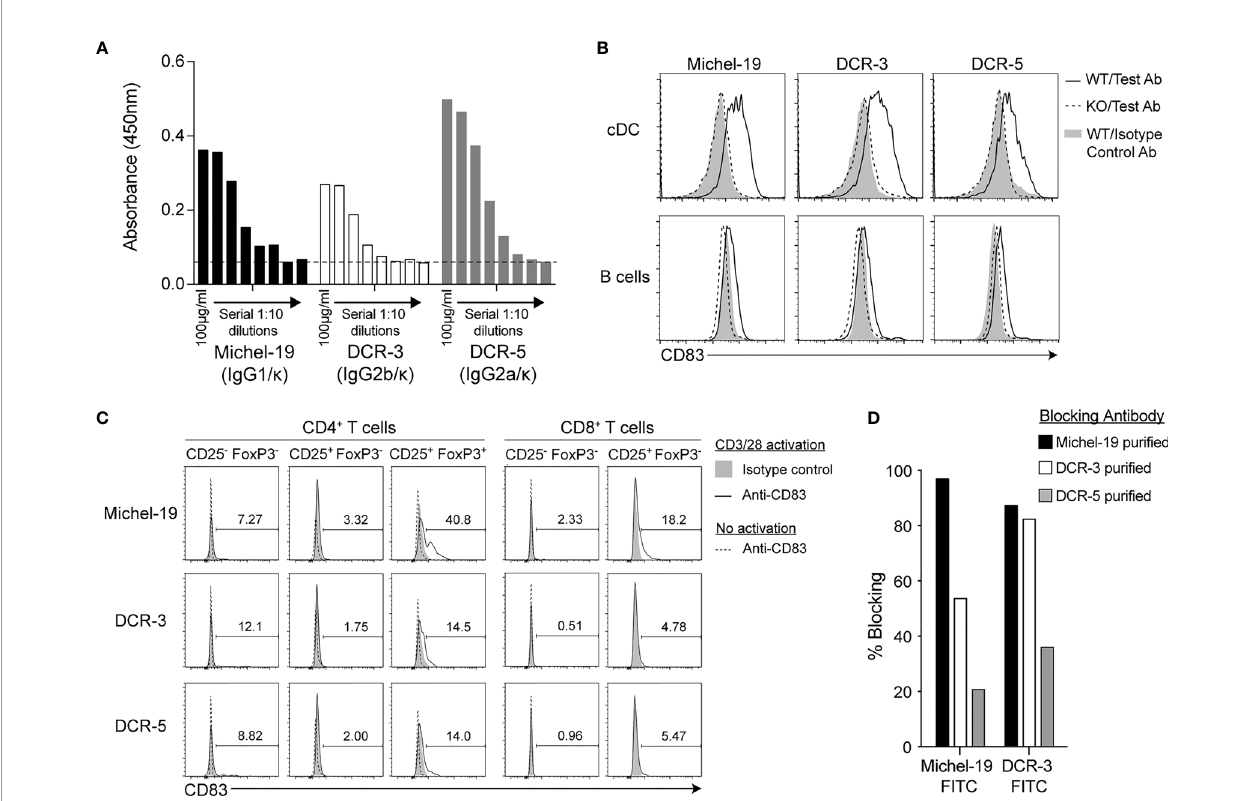
FIGURE 1 | Binding properties of rat anti-mouse CD83 antibodies DCR-5 and DCR-3. (A) Comparison of binding of DCR-5, DCR-3 and Michel-19 anti-CD83 antibody clones (1:10 serial dilutions starting at 100 µg/ml) to plates coated with recombinant mouse CD83-His by ELISA. Dashed line marks the absorbance in the no antibody control. Binding of 20 µg/ml Michel-19, DCR-3 or DCR-5 antibody (or respective isotype controls) was compared on the surface of (B) gated cDC and B cells (see Supplementary Figure 1A for gating strategy) in WT and CD83KO splenocytes cultured overnight with 1 µg/ml LPS or; (C) gated FoxP3 - CD25 - (naïve) and CD25 + (activated) CD8 + T cell cells and FoxP3 − CD25 − (naïve), FoxP3 − CD25 + (activated) and FoxP3 + CD25 + (Treg) CD4 + T cell subsets cultured with or without overnight stimulation with CD3/CD28 microbeads. Primary antibodies were detected using an anti-rat IgG (Fc-speci fi c)-AF488 antibody via fl ow cytometry. Percentage of CD83 + cells in CD3/28 stimulated cultures shown. No CD8 + CD25 + T cells detected in unstimulated cultures. (D) Binding of sub-saturating concentrations of FITC conjugated Michel-19 or DCR-3 to LPS stimulated A20 cells by fl ow cytometry was compared with and without initial blockade with saturating concentrations of puri fi ed Michel-19, DCR3 or DCR-5. Degree of blocking was calculated as percentage reduction in MFI with 0% indicating no blocking (MFI equivalent to anti-CD83 FITC antibody alone) and 100% indicating full blocking (MFI equivalent to binding of isotype-FITC